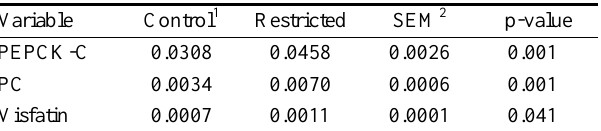
Table 5. Effect of limited concentrate feeding on mRNA concentrations of phosphoenol pyruvate carboxykinase (PEPCK), pyruvate carboxylase (PC), and visfatin in liver by RT-PCR relative to the reference gene (GAPDH) Variable